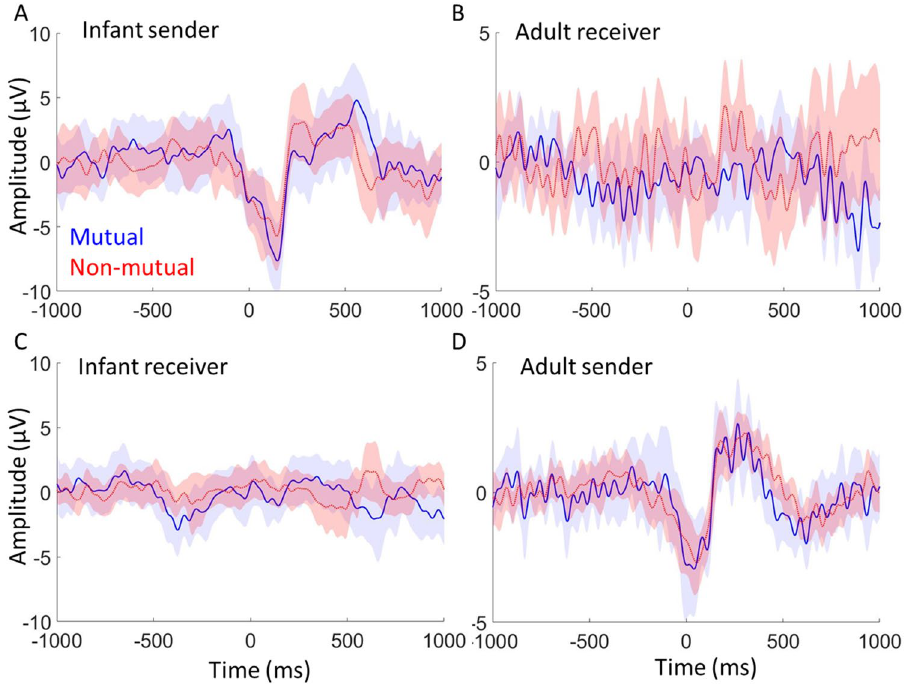
Figure 6. Event-related potentials time-locked to naturally occurring mutual and non-mutual gaze onsets. ( A ) Infant ERP relative to onsets of infant sender mutual gaze and non-mutual gaze onsets. ( B ) Adult ERP relative to adult receiver mutual and non-mutual gaze onsets. ( C ) Infant ERP relative to onsets of infant receiver mutual and non-mutual gaze onsets. ( D ) Adult ERP relative to adult sender mutual and non-mutual gaze onsets. For each the shaded area indicates 95% confidence intervals; thicker lines indicate grand average waveforms. Additional topoplots can be found in SM